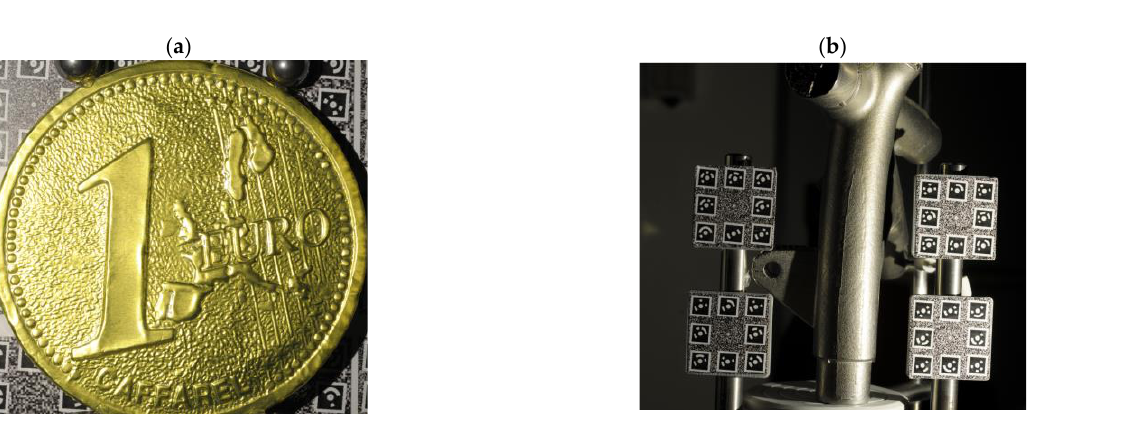
Figure 1. Examples of objects considered in this work and featuring non-collaborative surfaces (shiny, textureless). ( a ) a gold foiled surface shaped like a Euro coin featuring high reflective, very detailed structures [25]; ( b ) a metallic object with less reflectivity while featuring a geometrically complex shape [11].